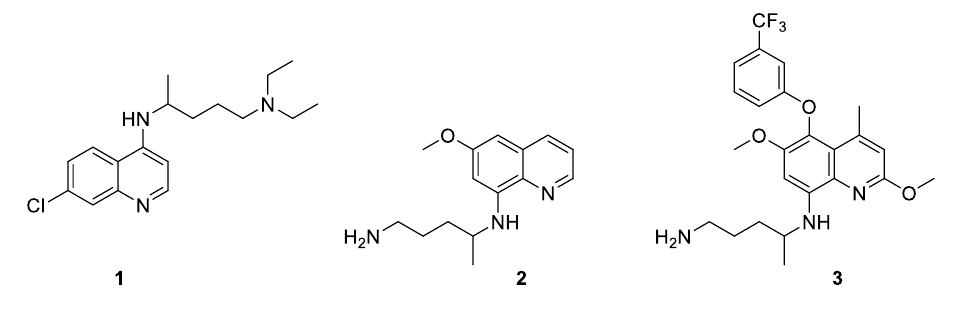
Figure 1. Structure of aminoquinolines ( 1 – 3 ).